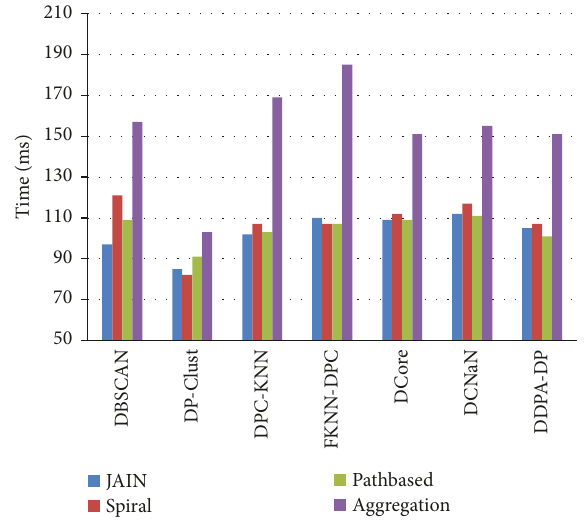
Figure 22: The runtimes in small data sets.